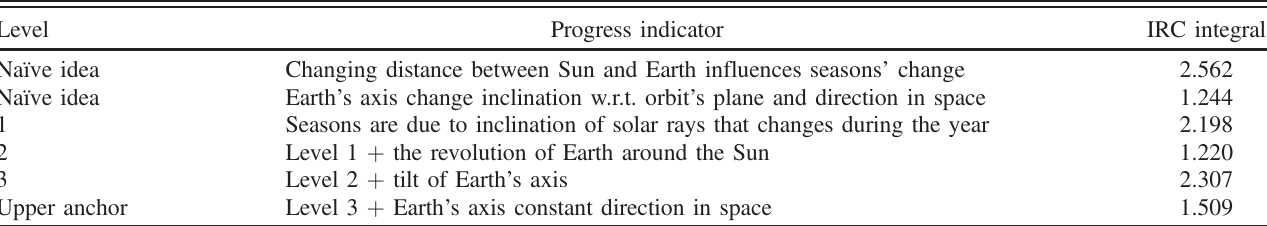
TABLE IV. Values of IRC integrals for learning progression about seasons ’ change.